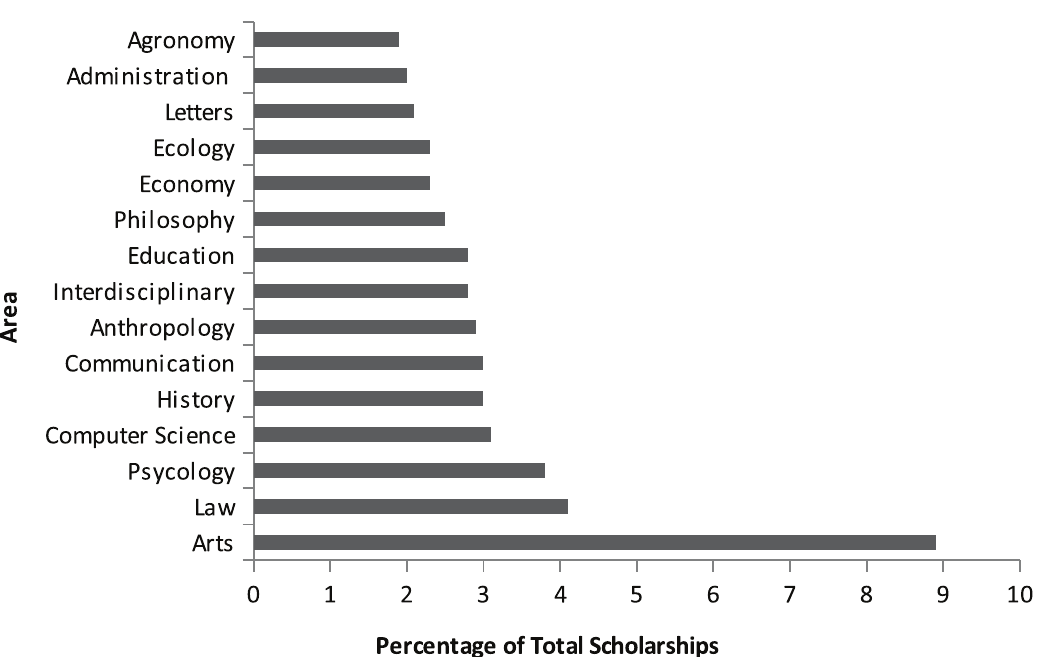
Figure 2 - Areas of knowledge of Brazilian full doctorate scholarship holders